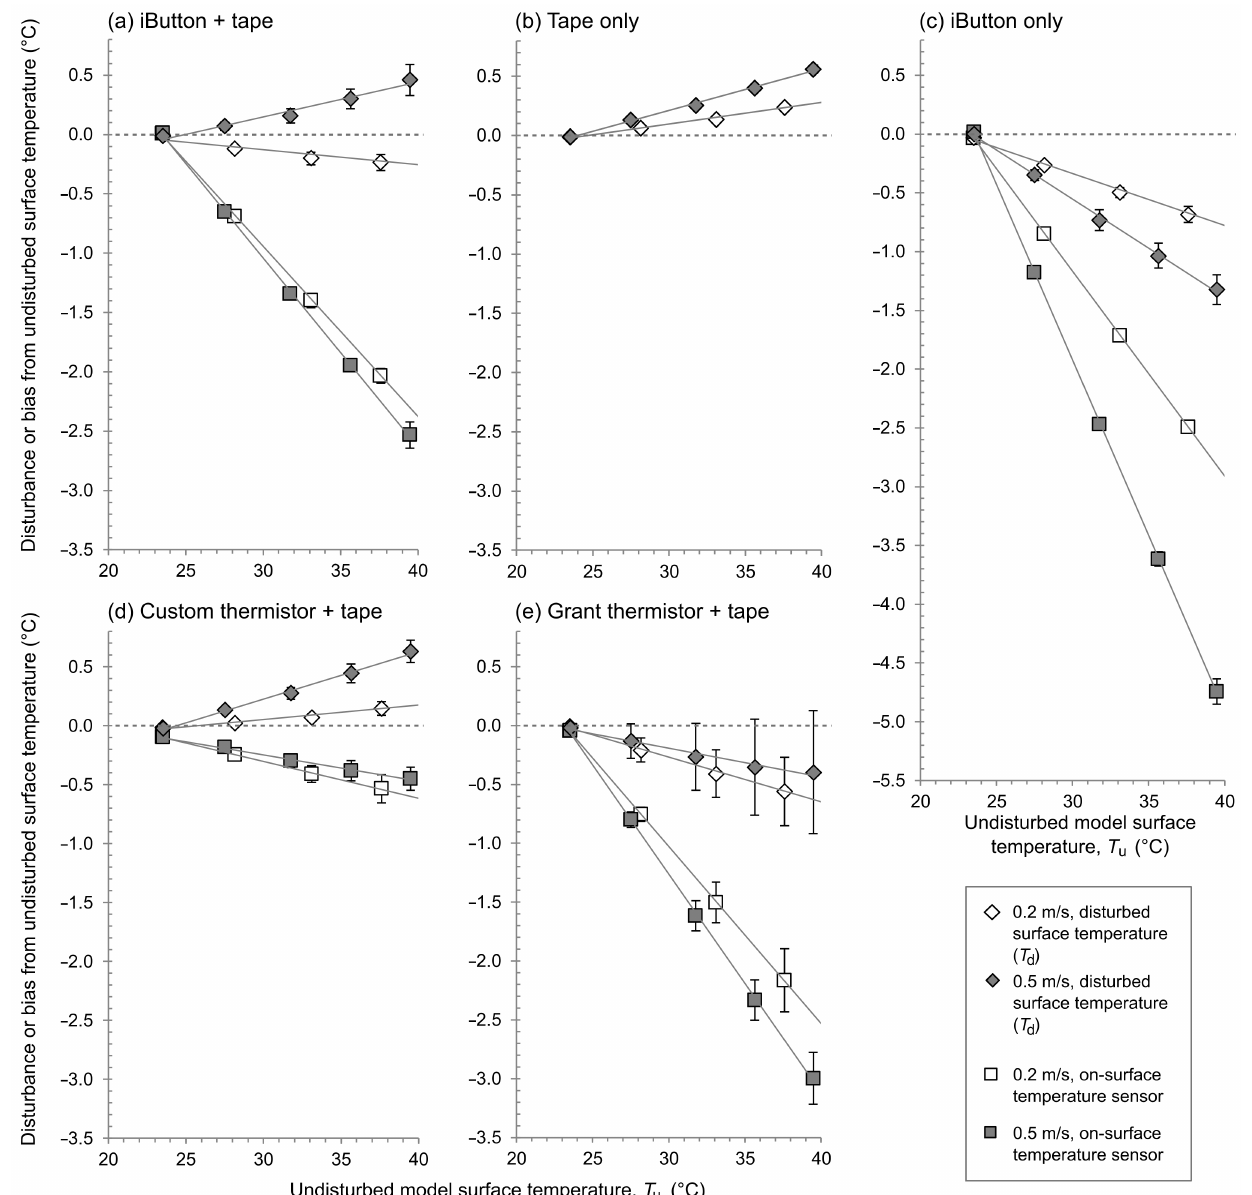
Figure 6. Magnitude of the local temperature disturbance caused by the surface skin temperature sensor and/or attachment and magnitude of the bias of the surface skin temperature sensor, each versus the model undisturbed temperature, under each air velocity condition (0.2 and 0.5 m · s − 1 ) and for each surface condition ( a – e ). Plotted data points and error bars are mean ± 95% confidence intervals (in some cases, the confidence intervals are too small to be visible in the figure); solid gray lines are regression lines fitted to mean data for illustrative purposes. Data beyond 40 ◦ C (the last steady state for 0.2 m · s − 1 air velocity) are not shown here to maintain emphasis on a physiological temperature range. T d , disturbed local surface temperature of the model; T u , undisturbed local surface temperature of the